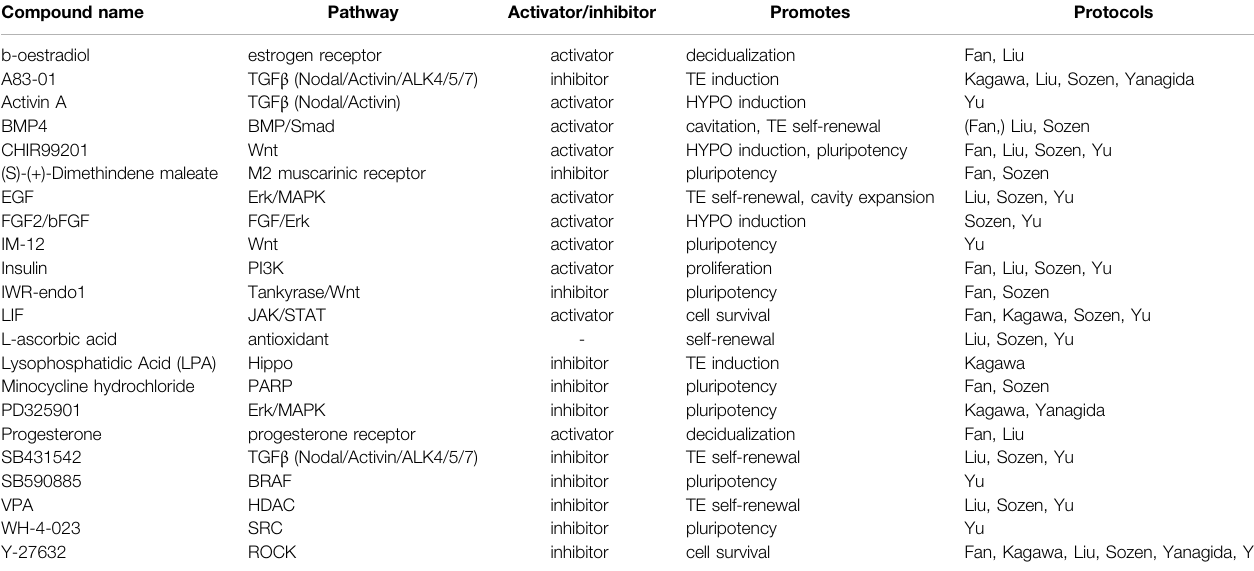
TABLE 4 | Small molecules applied in human blastoid protocols. When a protocol is listed in brackets, the molecule is used in a screening or cell culture maintenance medium, but not included in the blastoid generation protocol. Compound name